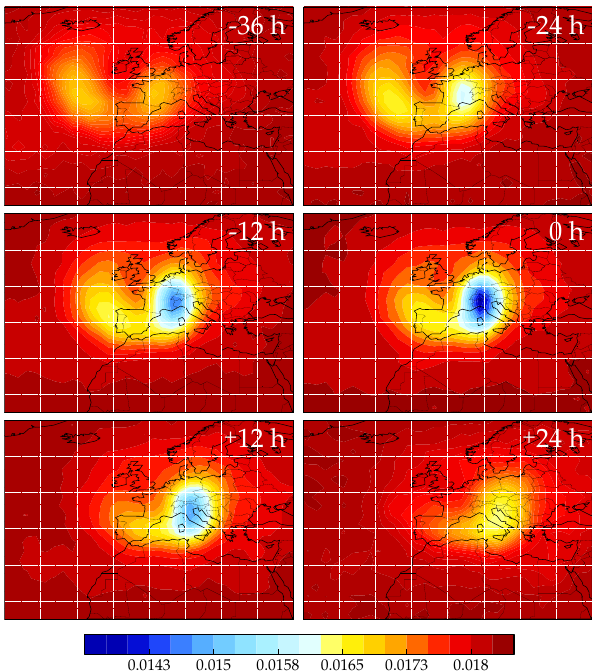
Fig. 3. Time evolution of the relevance map on the 500hPa atmo- spheric pressure level for the Mar´ecottes station. The values are the CRPS